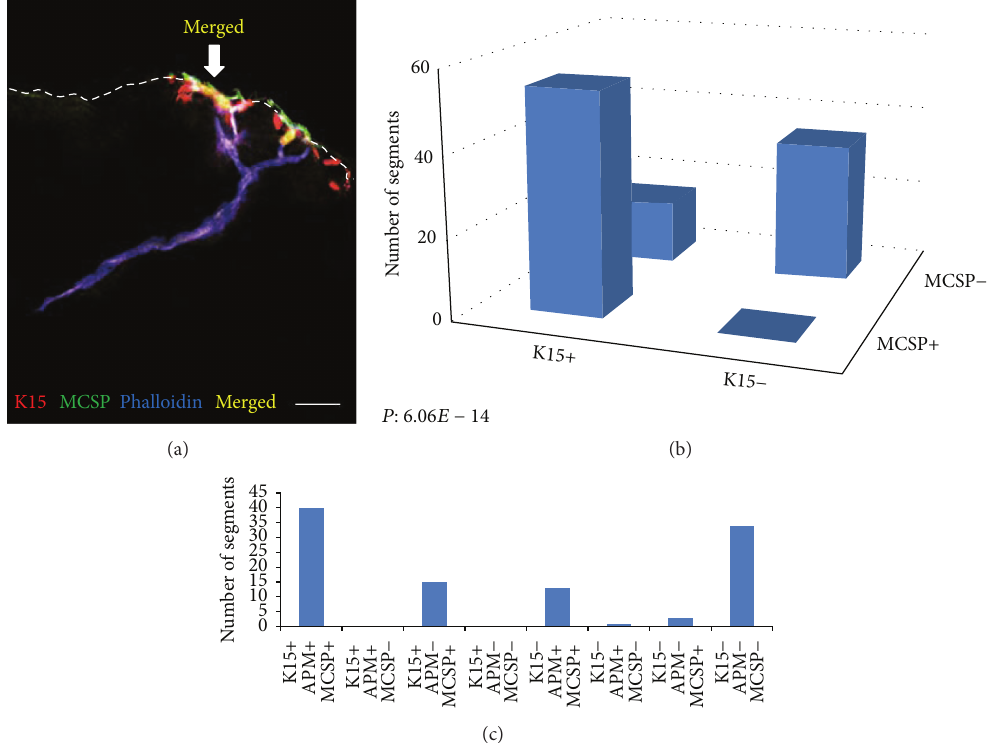
Figure 7: Colocalization of stem cell markers. (a) Marked overlap (yellow) of K15 (red) and MCSP (green) expression in the basal epidermis. (b)AstrongcorrelationbetweenMCSPandK15wasdemonstrated.(c)Asignificantpositivethree-waycorrelationwasdemonstratedbetween phalloidin (APM), MCSP, and K15 expressing cells. Scale bar: 100 𝜇